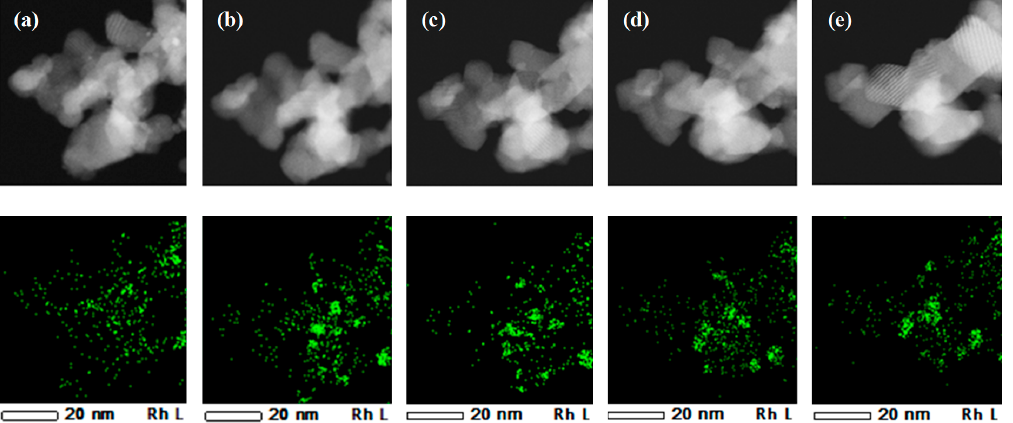
Figure 2. TEM images and EDS mapping of Rh in Rh/ZrO 2 under vacuum conditions at ( a ) 300 °C, ( b ) 900 °C, ( c ) 950 °C, ( d ) 1000 °C, and ( e ) 1050 °C.